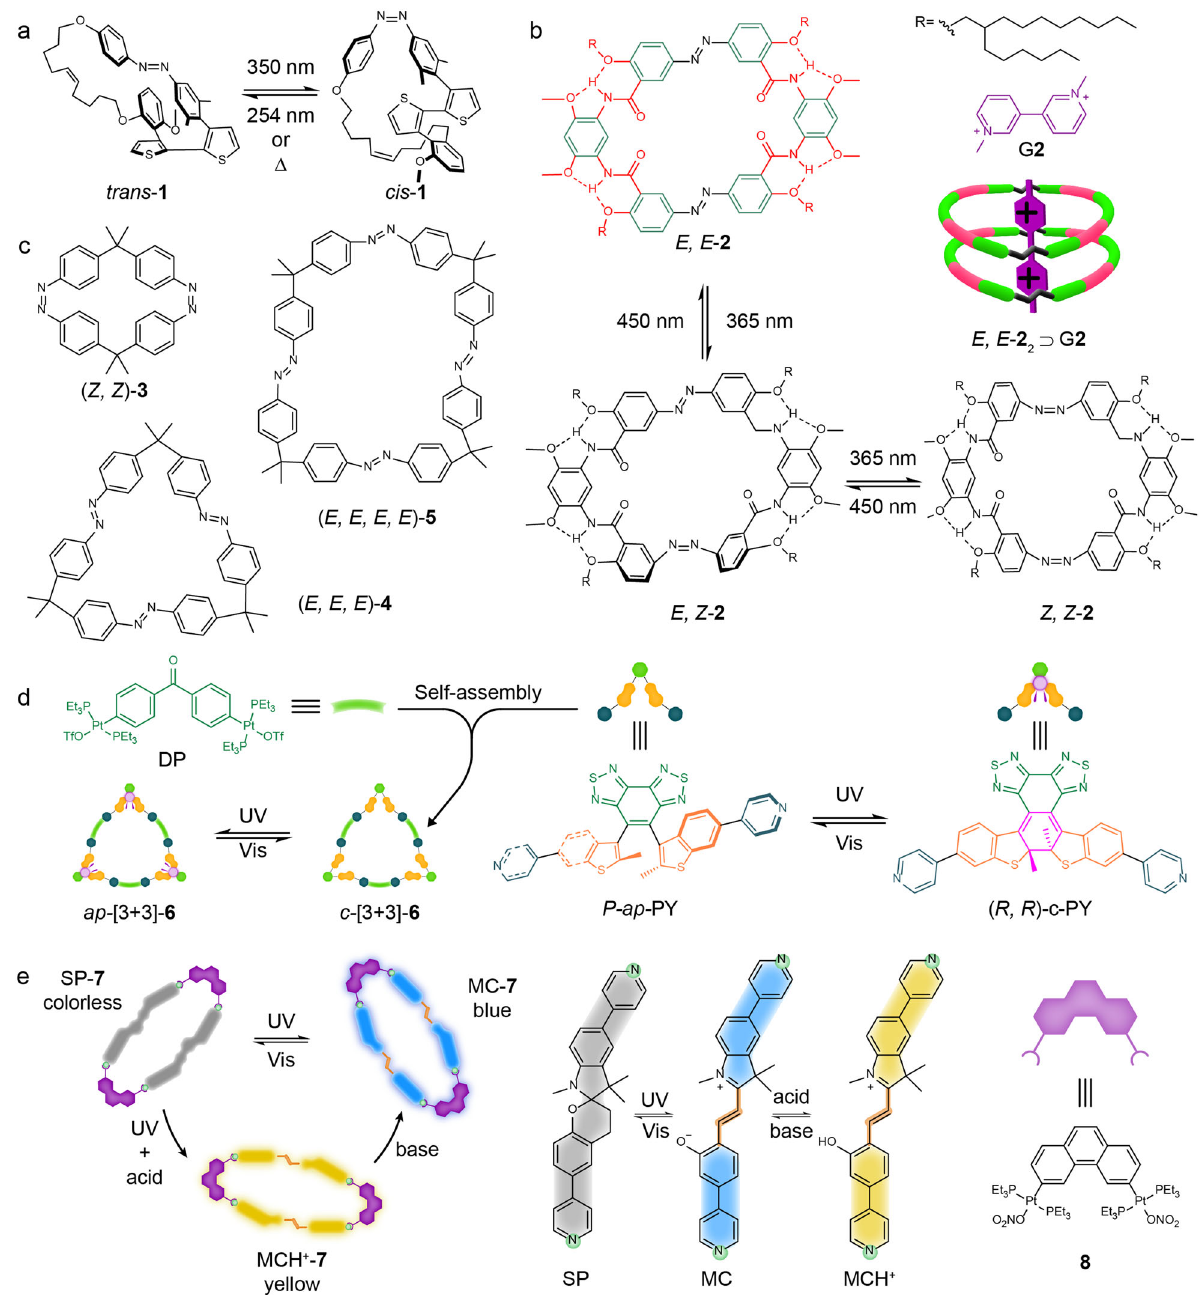
Fig. 1 Photo-responsive macrocycles. a planar twist of the inside connected dithiophene unit photoinduced by the azo-based macrocycle 1 23 . b photo- tunable geometries of a hydrogen-bonded azo-macrocycle 2 and its speci fi c binding model (2:1) with guest molecule G 2 24 . c the chemical structures of biazobenzophane 3 , triazobenzophane 4 , tetraazobenzophane 5 contained different azo group numbers inside respectively 27 . d the chemical structures of e the photo-controlled topology and acidochromic property of metallacycle 7 31 , the chemical structures and reversible isomerization of the spiropyran- functionalized dipyridyl donor and di-Pt(II) acceptor 8